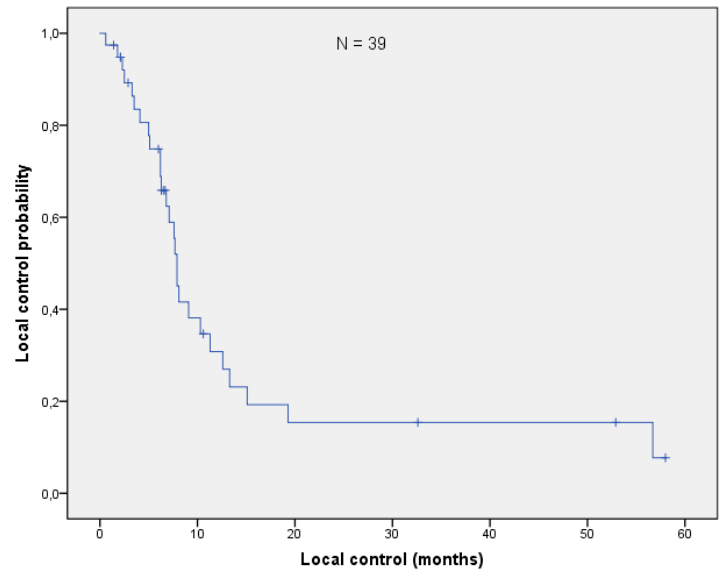
Figure 3. The median local control was 7.9 months (95% CI: 7.3–8.5).